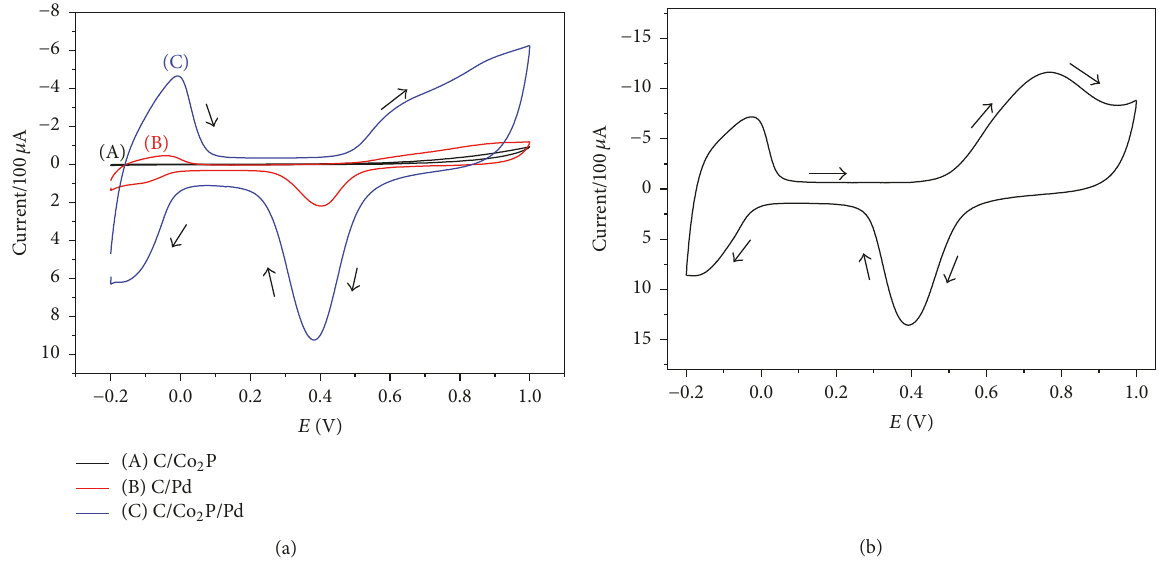
Figure 6: (a) CVs of the C/Co 2 P/GCE (A), C/Pd/GCE (B), and C/Co 2 P/Pd/GCE (C) in 0.5 M H 2 SO 4 solution. Scan rate: 50 mV/s. (b) CV of the C/Co 2 P/Pd/GCE in 0.5 M H 2 SO 4 solution containing 5mM formaldehyde from − 0.2 V to 1.0V at 50 mV/s.